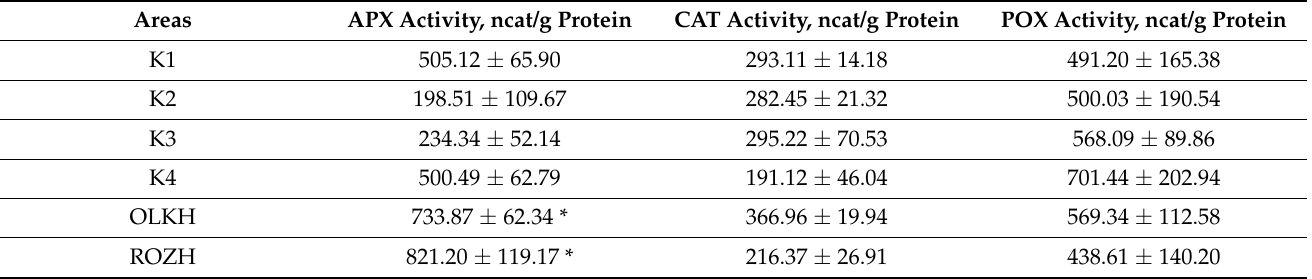
Table 4. The activity of antioxidant enzymes in H. tuberosus plants growing in pollution-free zones and in areas with 137 Cs contamination. * corresponds to p < 0.05 significance